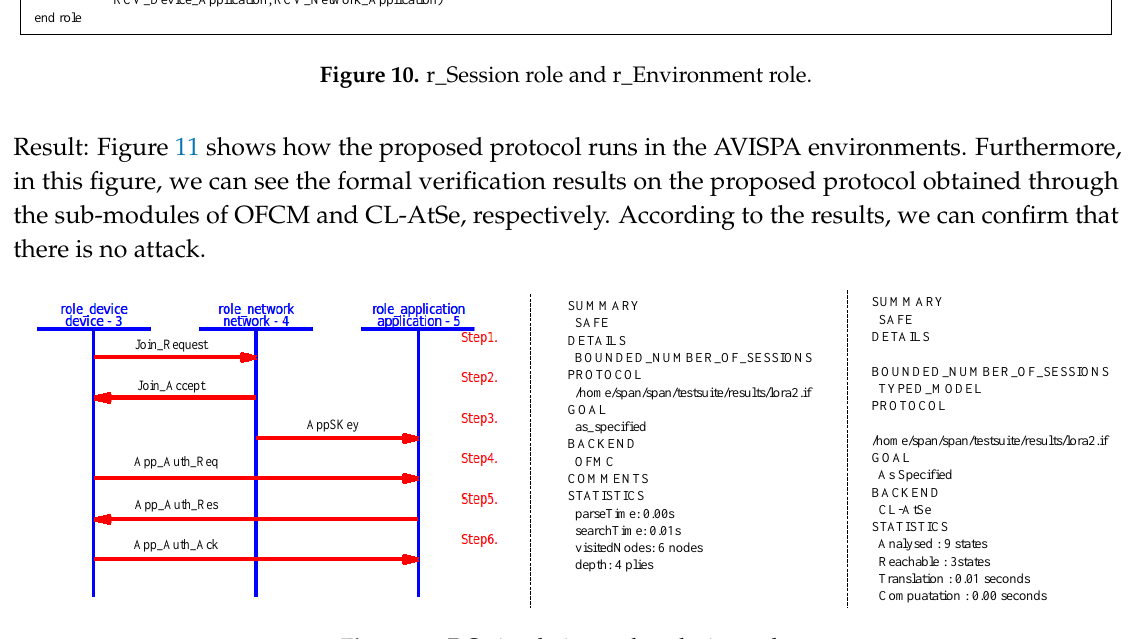
Figure 11. DO simulation and analysis